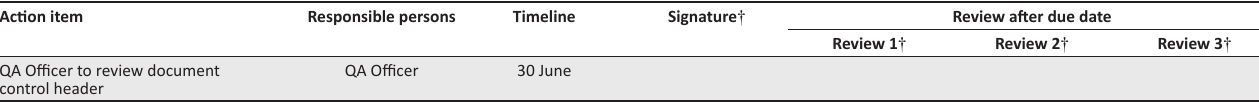
TABLE 3: Example of laboratory action plan derived from the summary of assessment findings. Action item QA Officer to review document control